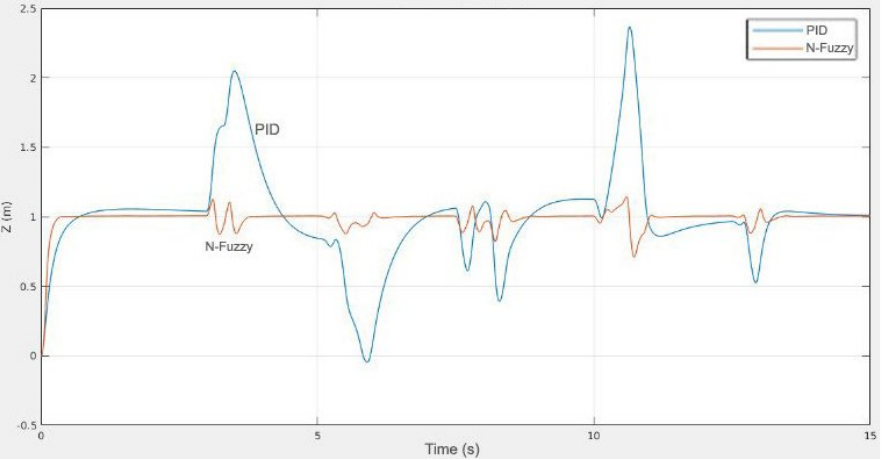
Figure 21. The results compare the Z position (attitude) of the Neural-Fuzzy controller and the classic PID controller (wind